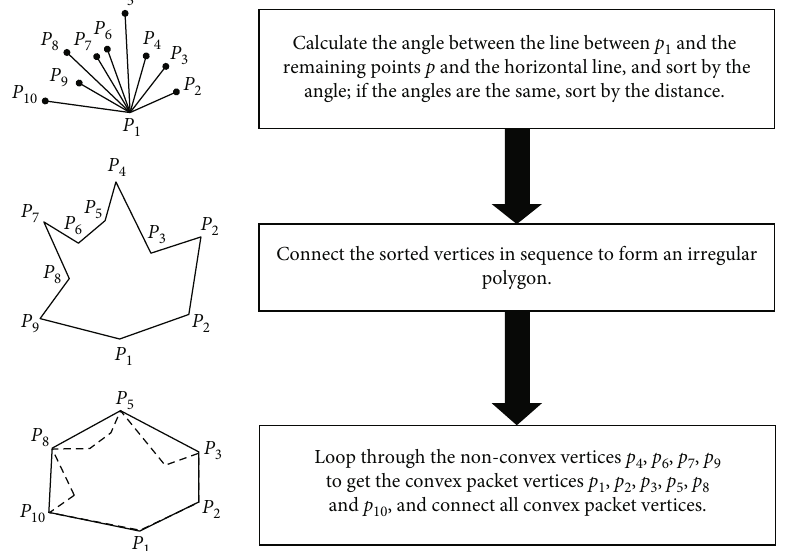
Figure 1: Construction of a convex packet using the Graham